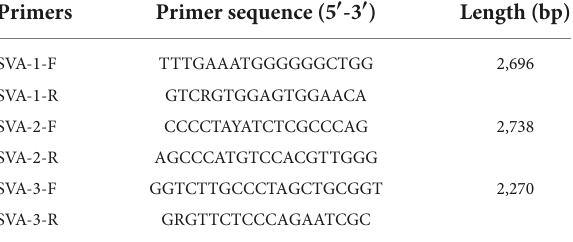
TABLE 2 Primers for full-length SVA